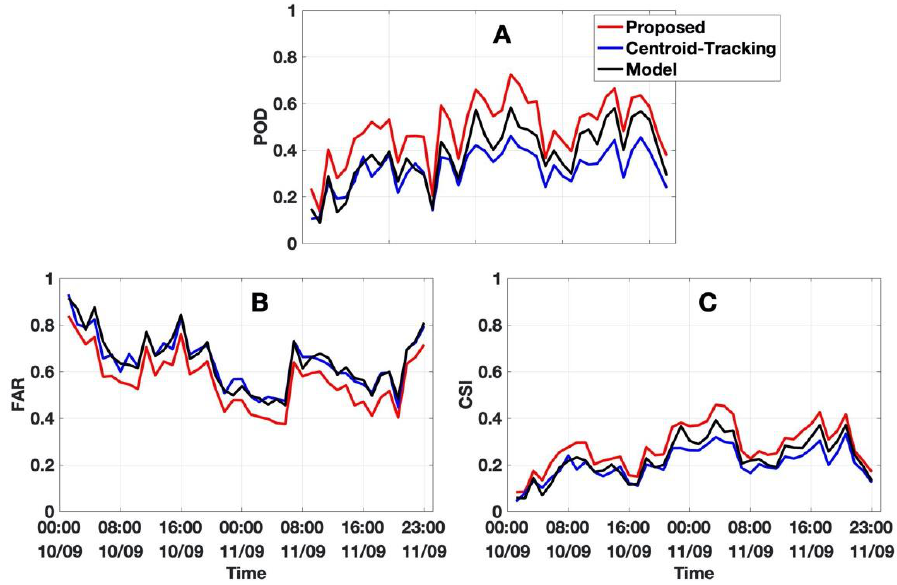
Figure 12. Similar to Figure 11, with 48 h of data from Hurricane Irma (10–11 September 2017).